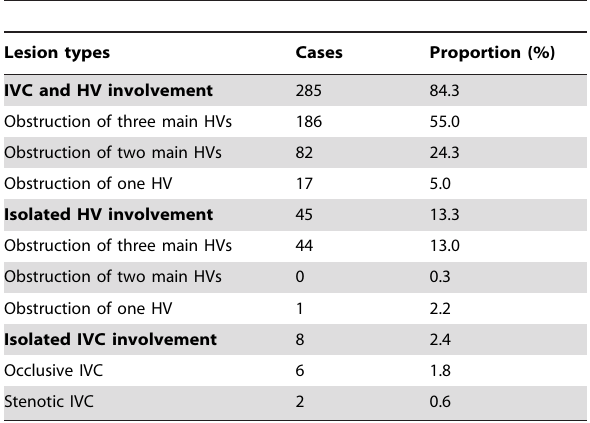
Table 1. Types distribution of venous lesions in patients with